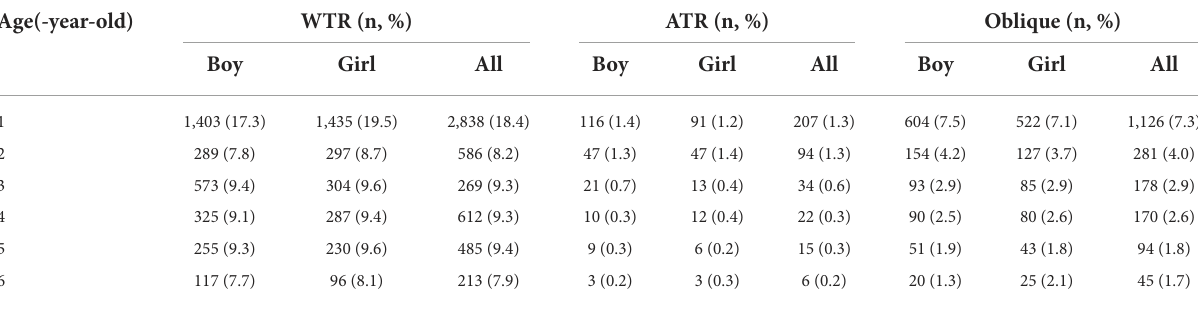
TABLE 2 Prevalence of different astigmatism types of the 1-6 years old children in the Changsha Children Eye Study. Age(-year-old)